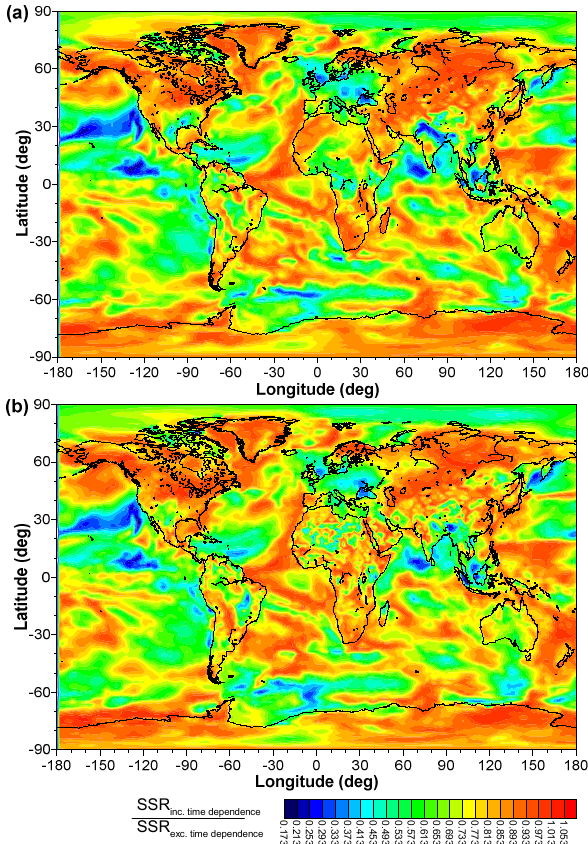
Fig. 12. SSR incl. time /SSR excl. time ratios for (a) T 0 max and (b) T 0 Fig.12. SSR incl.time /SSR excl.time ratiosfor(a) T 0 max and(b) T 0 min . Theratioswerederivedbydividingthe T 0 max The ratios were derived by dividing the T 0 max ( T 0 ( T 0 min )timeseriesfromtheHadGEM2-ESRCP4.5simulationandthe T 0 max ( T 0 min )fromtheregressionmodel from the HadGEM2-ES RCP 4.5 simulation and the T 0 max ( T 0 based on the same emissions scenarios where (i) the time dependence was included (SSR incl.time , Eq. (6)), and from the regression model based on the same emissions scenarios (ii) time dependence was excluded (SSR excl.time , Eq. (2)). where (i) the time dependence was included (SSR incl. time , Eq. 6), and (ii) time dependence was excluded (SSR excl. time , Eq. effects of short-term and long-term forcing agents on the derivation of the regression model fit- coefficients will be investigated in a future study.